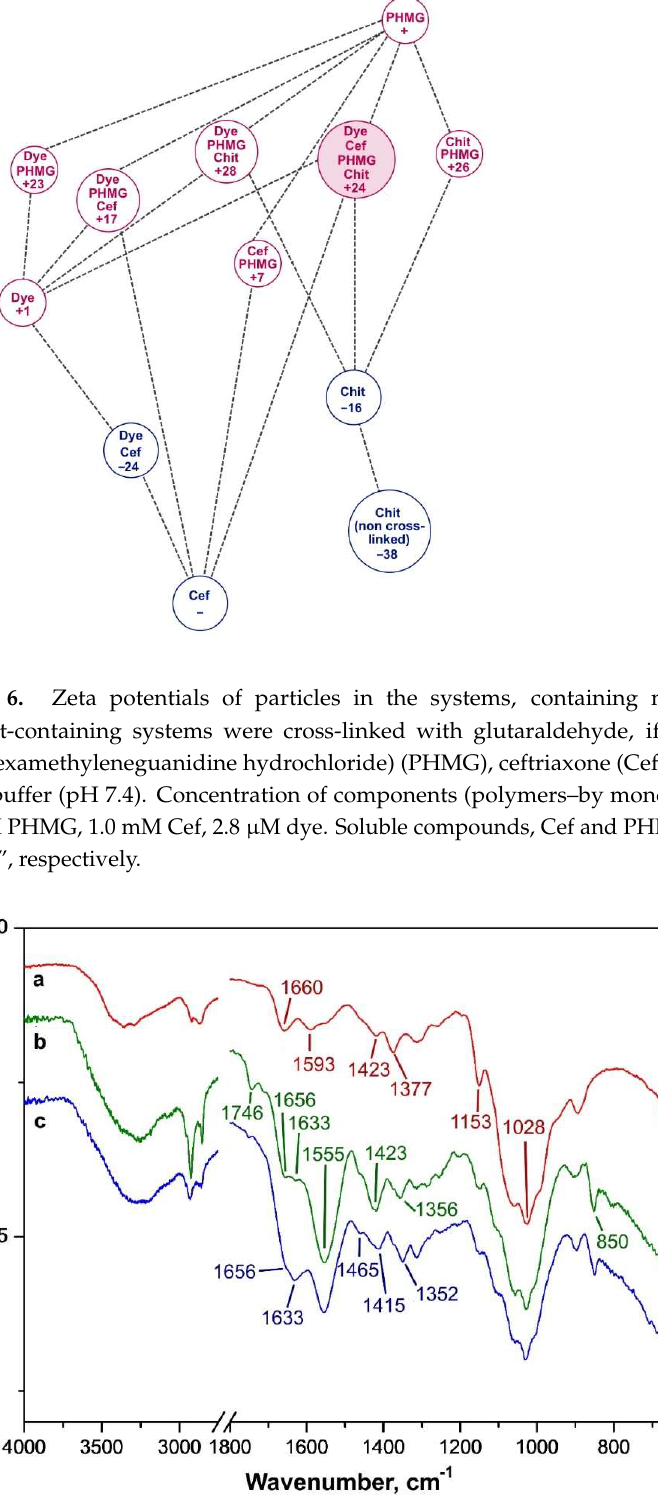
Figure 7. FT-IR spectra of solid samples of chitosan ( a ), maleated chitosan ( b ) and containers maleated chitosan–PHMG–ceftriaxone–dye ( c ).